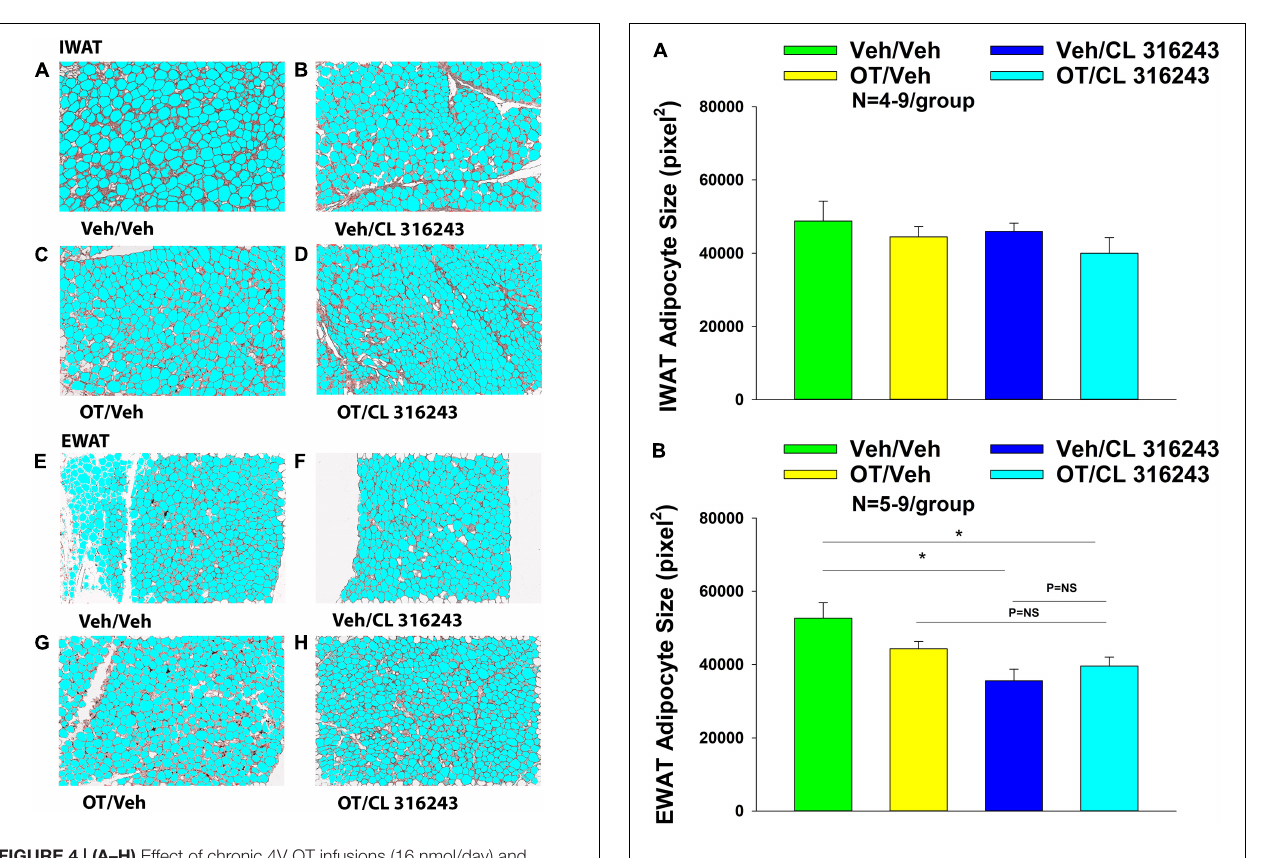
FIGURE 5 | (A,B) Effect of chronic 4V OT infusions (16 nmol/day) and systemic beta-3 receptor agonist (CL 31643) administration (0.5 mg/kg) on adipocyte size in IWAT and EWAT in male DIO rats. (A) Adipocyte size (pixel 2 ) was measured in IWAT from rats that received chronic 4V infusion of OT (16 nmol/day) or vehicle in combination with daily CL 316243 (0.5 mg/kg) or vehicle treatment ( N = 4–9/group). (B) Adipocyte size was measured in EWAT from rats that received chronic 4V infusion of OT (16 nmol/day) or vehicle in combination with daily CL 316243 (0.5 mg/kg) or vehicle treatment ( N = 5–9/group). Data are expressed as mean ± SEM. * P < 0.05 OT vs.